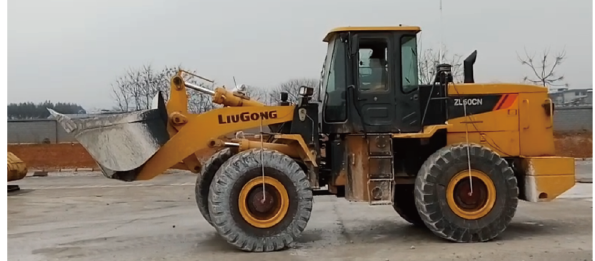
Figure 4. Experimental wheel